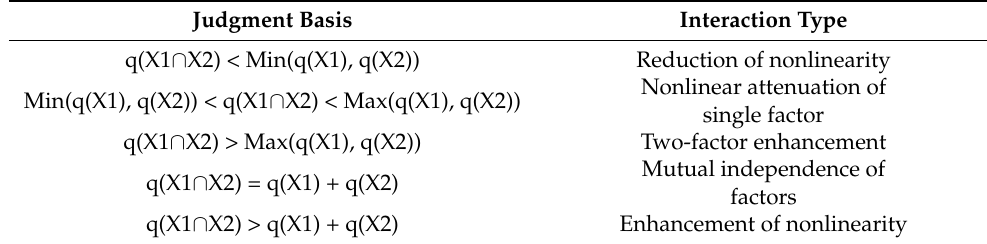
Table 5. Factor interaction type and basis for